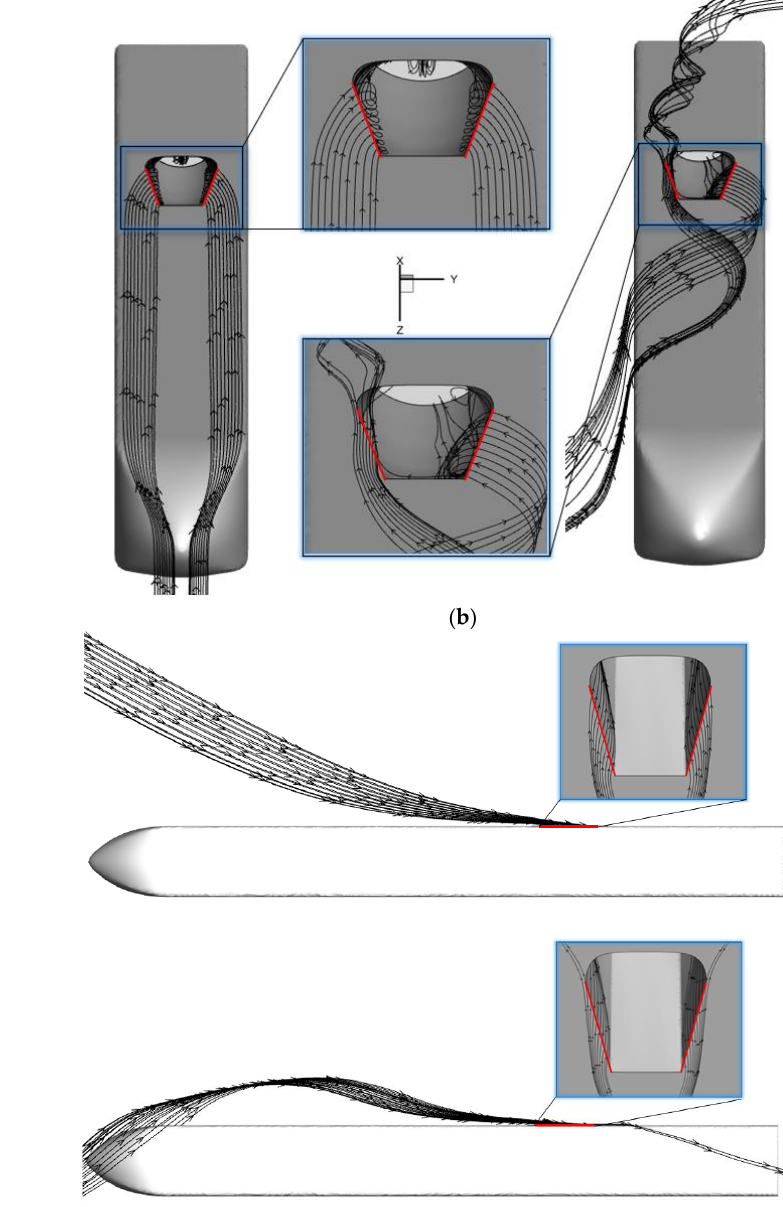
Figure 1. Intake mechanism intention of submerged inlet under different flight conditions.(( a ) Intake mechanism intention when sideslip angle and angle of attack are small, ( b ) Intake mechanism intention when sideslip angle is large and angle of attack is small, ( c ) Intake mechanism intention when the sideslip angle is small and the angle of attack is positive and large, ( d ) Intake mechanism intention when sideslip angle is small, angle of attack is negative and large)